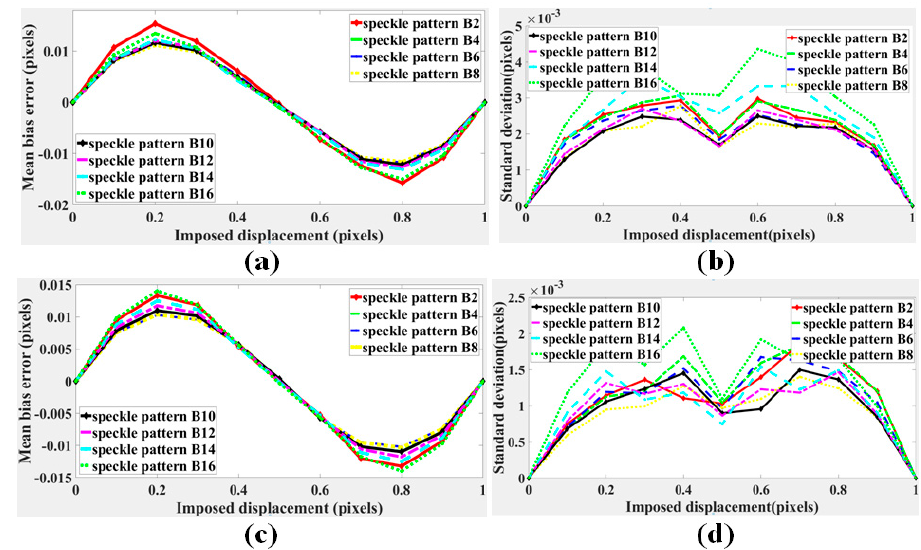
Figure 10. ( a ) Mean bias errors and ( b ) standard deviations of of speckle patterns displacements in group B calculated with the subset of 31 × 31 pixels. ( c ) Mean bias errors and ( d ) standard deviations of speckle patterns displacements in group B calculated with the subset of 61 × 61 pixels.